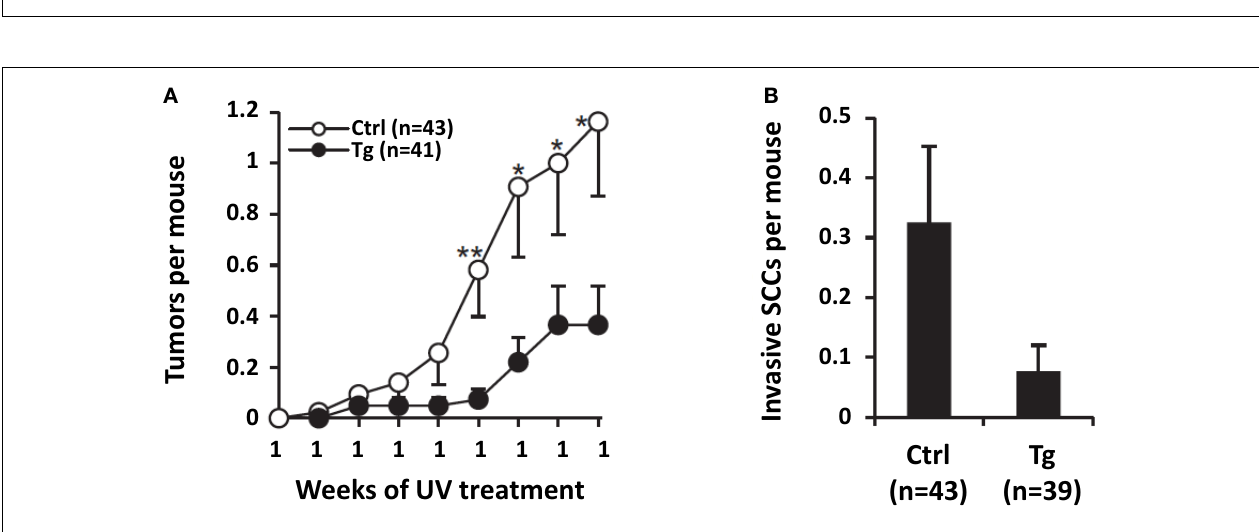
FIGURE 10 |Topical applications of caffeine to UVB-pretreated high-risk mice increase the percentage of mitotic cells with caspase 3 in tumors . High-risk UVB-pretreated mice were treated topically with caffeine for 18weeks as described in Table 2 . Mitotic cells with caspase 3 were measured.Taken from Lu et al. (2011).